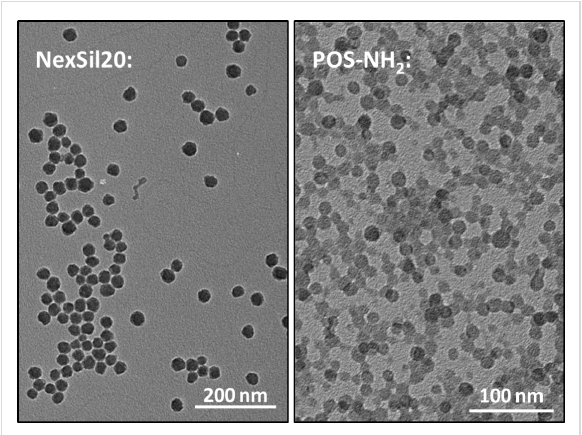
Figure 1: TEM micrographs of NexSil20 and POS-NH 2 nanoparticles after dry preparation from an aqueous dispersion.